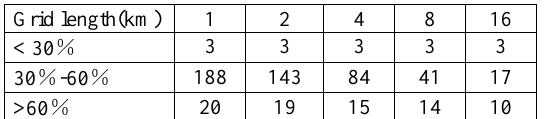
According to the statistical data, the R (I) and N (RI) values of each rainfall area were labeled on the double logarithmic coordinate map. The least squares fitting method was used to fit the straight line, and the fitting curve of the distribution of landslide disaster points in the annual rainfall area of the Sichuan Basin was obtained, as shown in Figure 4.